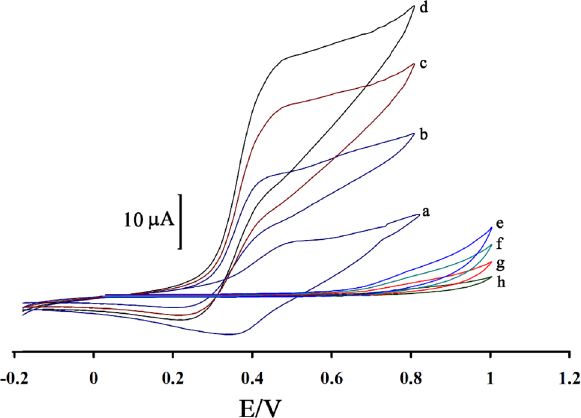
Figure 3. Cyclic voltammograms of BPOFc/BMPF6/NiO-SWCNTs/CPE ( a ); BPOFc/NiO-SWCNTs/CPE in the presence of 1.0 mM N-acetylcysteine ( b ); BPOFc/BMPF6/CPE in the presence of 1.0 mM N-acetylcysteine ( c ); BPOFc/BMPF6/NiO-SWCNTs/CPE in the presence of 1.0 mM N-acetylcysteine ( d ); BMPF6/SWCNTs/ CPE in the presence of 1.0 mM N-acetylcysteine ( e ); BMPF6/CPE in the presence of 1.0 mM N-acetylcysteine ( f ); SWCNTs/CPE in the presence of 1.0 mM N-acetylcysteine ( g ) and CPE ( h ) in the presence of 1.0 mM N-acetylcysteine. Condition; pH = 7.0 and scan rate 20 mV/s.